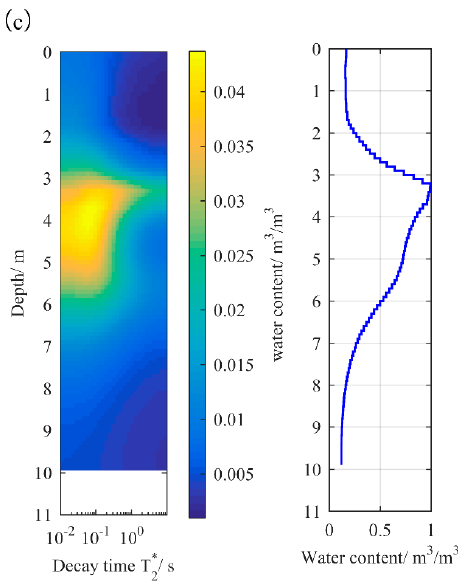
Figure 8. The inversion results of underground MRS. ( a ) inversion results for a water level of 1.0 m; ( b ) inversion results for a water level of 1.5 m; ( c ) inversion results for a water level of 2.0 m.